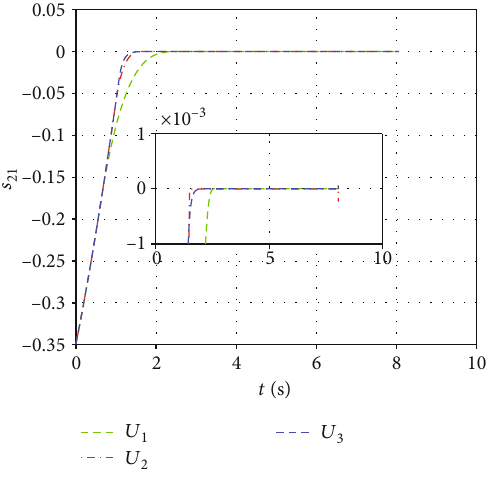
Figure 6: Dynamic error surfaces s